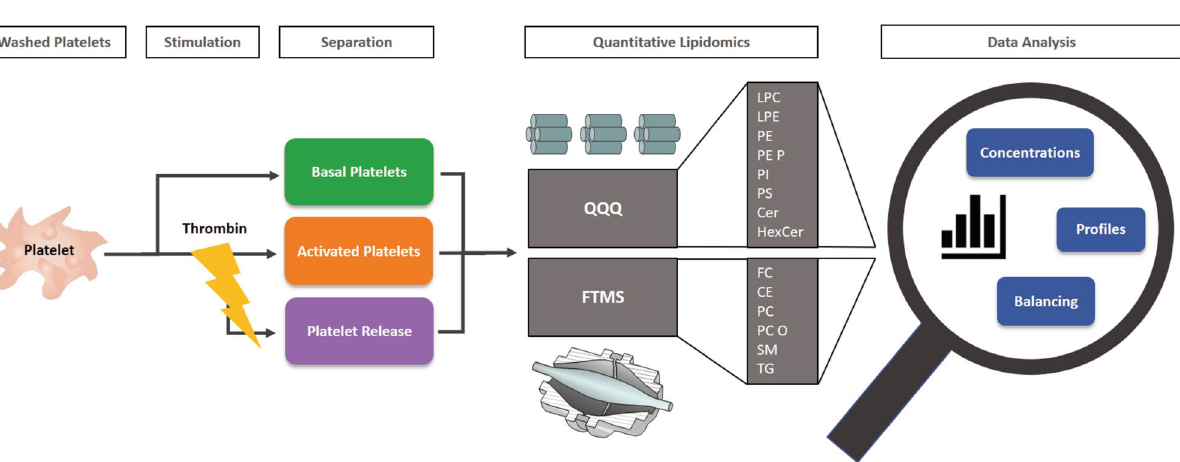
Figure 1. Workflow platelet release assay. Washed platelets were adjusted to a defined cell count (100/nL). One aliquot was stored immediately as basal platelets, a second aliquot was stimulated by thrombin. After a 15 min stimulation and centrifugation, pellet and supernatant were stored as activated platelets and their release, respectively. Samples were analyzed by quantitative lipidomics using flow injection analysis (FIA) coupled with high-resolution mass spectrometry (HRMS) as well as tandem mass spectrometry (MS/MS). The study covered major lipid classes: cholesteryl ester (CE), ceramide (Cer), free cholesterol (FC), hexosylceramide (HexCer), lysophosphatidylcholine (LPC), lysophosphatidylethanolamine (LPE), phosphatidylcholine (PC), phosphatidylcholine ether (PC O), phosphatidylethanolamine (PE), PE plasmalogens (PE P), phosphatidylinositol (PI), phosphatidylserine (PS), sphingomyelin (SM), trigylcerides